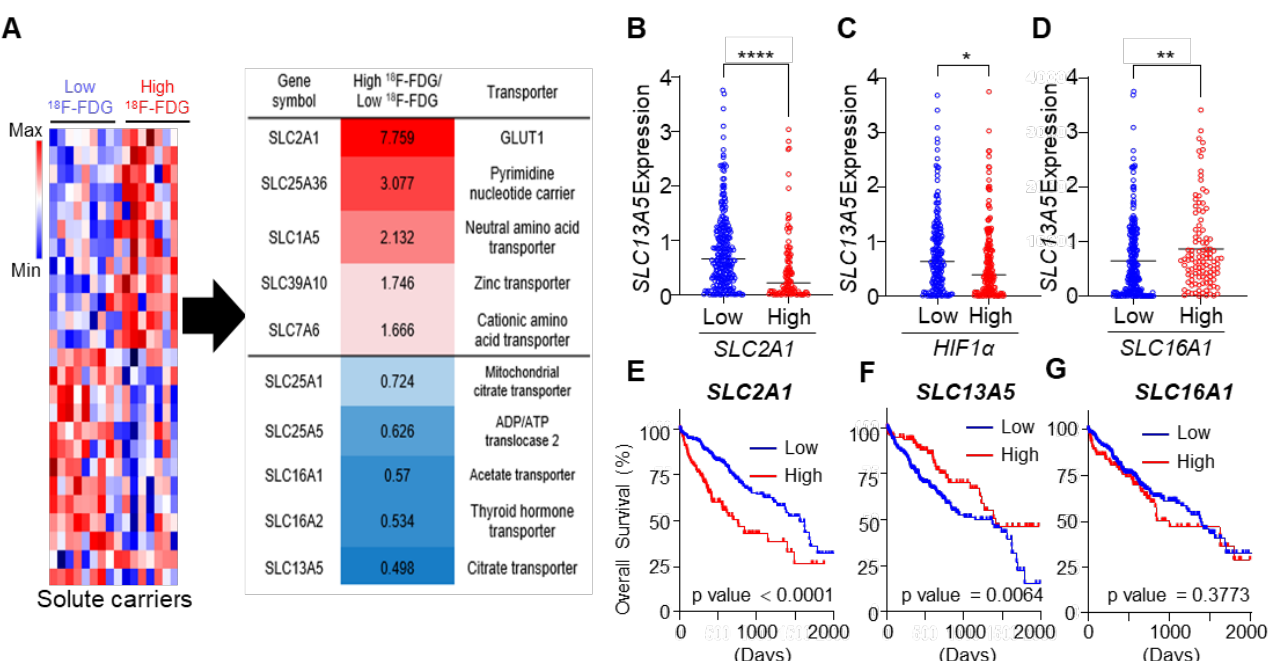
Figure 1. Reciprocal expression of solute carrier (SLC)-related gene in patients with hepatocellular carcinoma (HCC) with high-and low-glycolysis. ( A ) Heat-map of SLC-related genes of frozen tissues from patients with HCC with high 18 F-fluorodeoxyglucose (FDG) ( n = 8) or low 18 F-FDG ( n = 8). ( B – D ) The expression of SLC13A5 with low and high SLC2A1 ( B ) , HIF1 α ( C ), and SLC16A1 ( D ) expression groups (70-30 percentile) in the Cancer Genome Atlas (TCGA) dataset of HCC patients. ( E – G ) The median OS based on the TCGA dataset of HCC patients in low and high expression groups (70-30 percentile) in indicated genes. Data were represented as mean ± SEM and were compared using unpaired two-tailed t -tests and log-rank tests. * p < 0.05, ** p < 0.01, **** p < 0.0001.